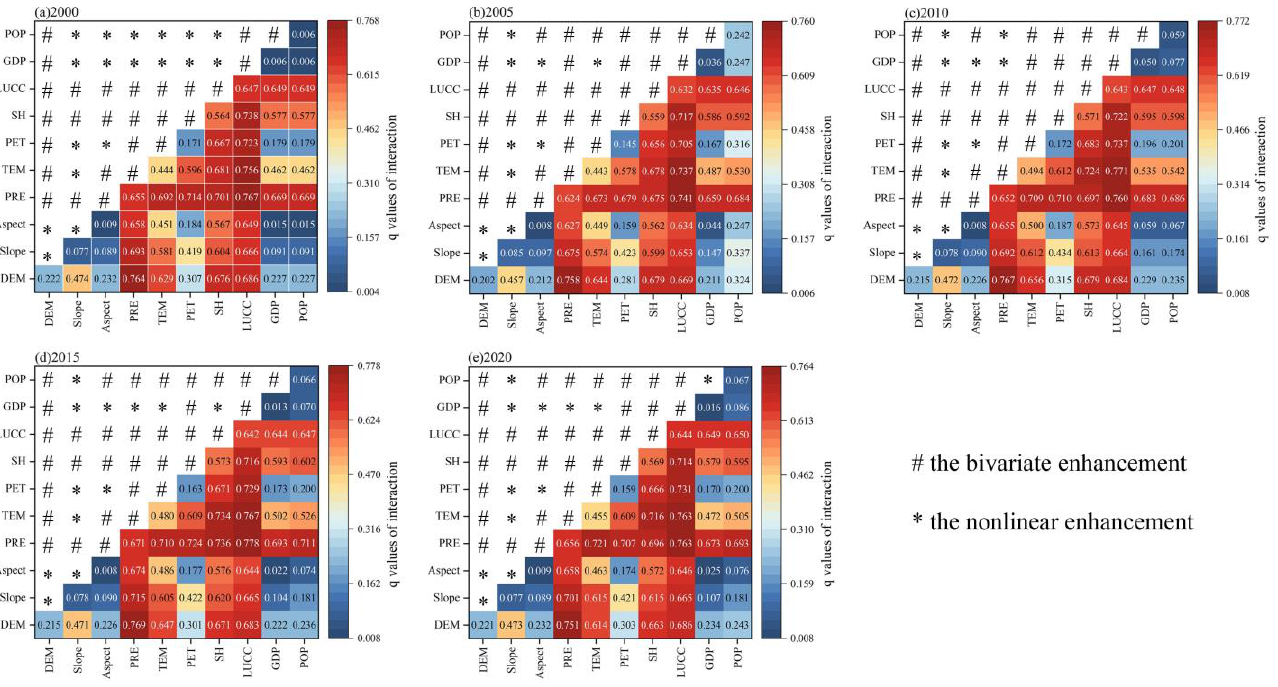
Figure 7. The interactive effect between influencing factors and NPP.